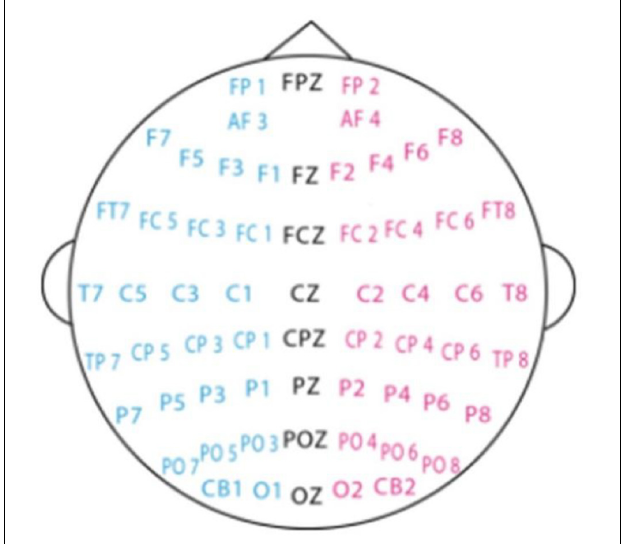
FIGURE 2 | EEG electrode